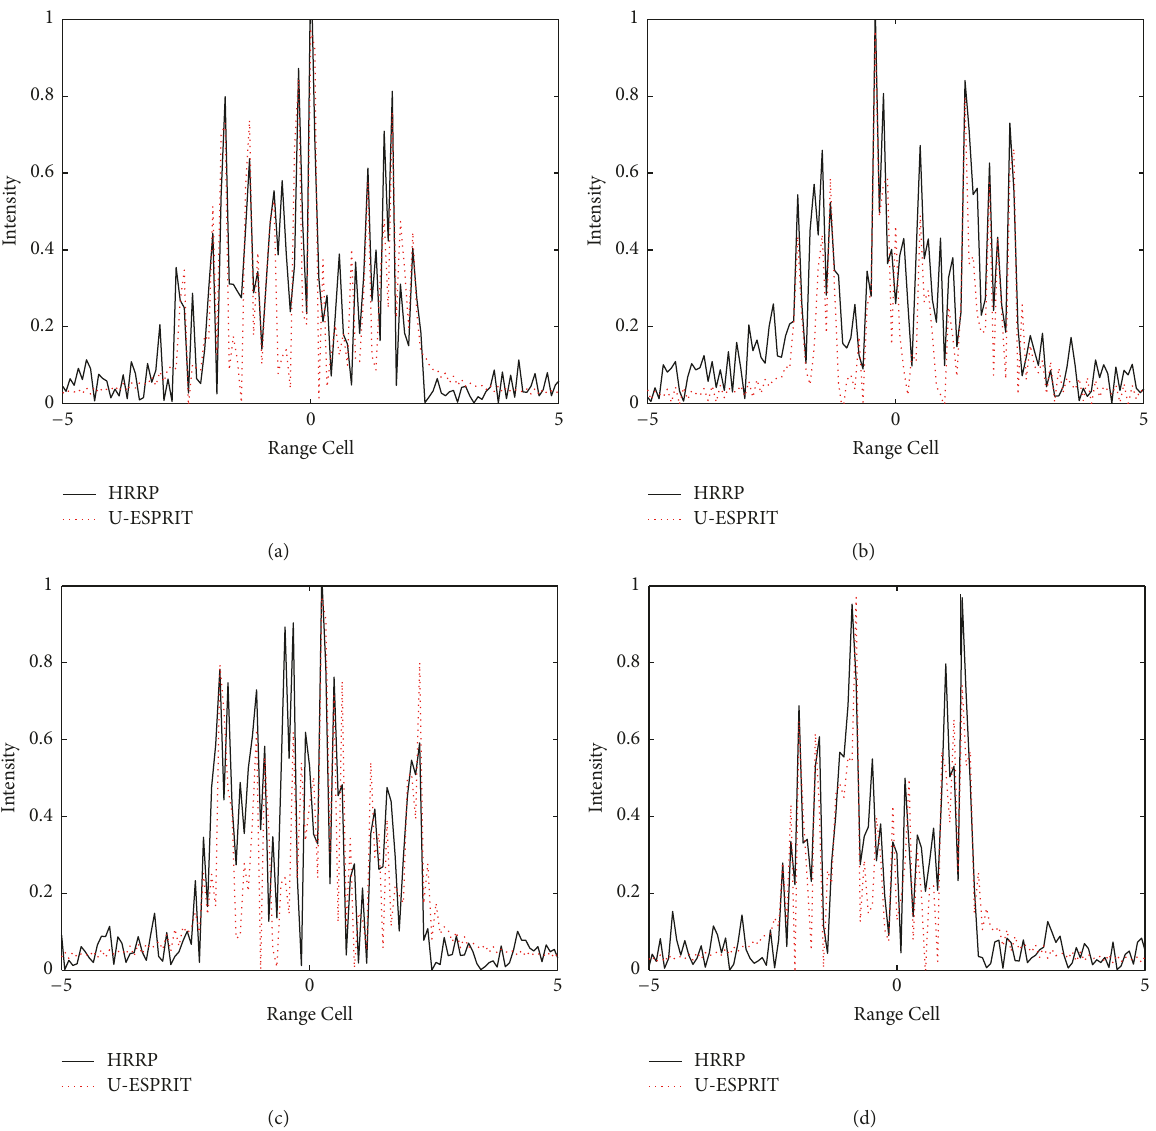
Figure 3: Normalized range profiles obtained by unitary ESPRIT and FFT with SNR equaling 5dB at an azimuth of 30 degrees: (a) Target 1, (b) Target 2, (c) Target 3, and (d) Target